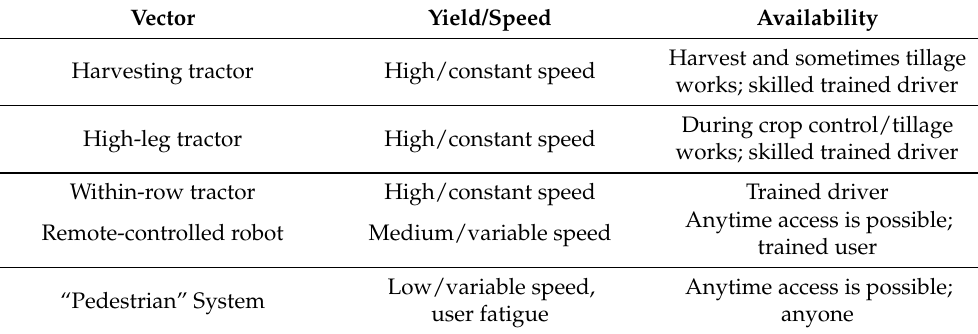
Table 3. Description of the vectors on which the acquisition system may be mounted. Vector